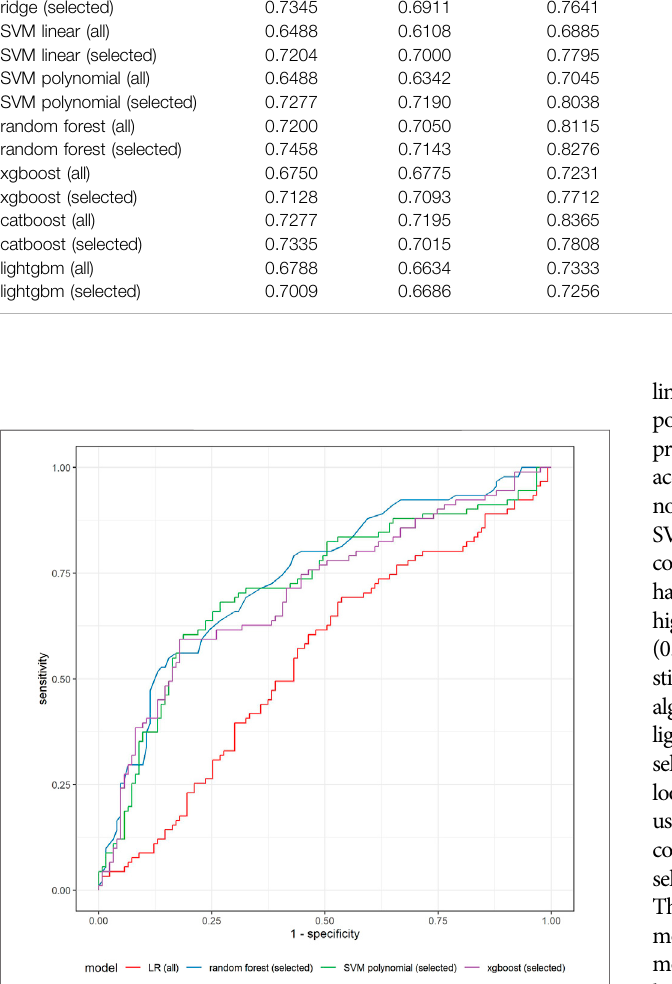
FIGURE 4 | Comparison of ROC curves of selected models in the validation